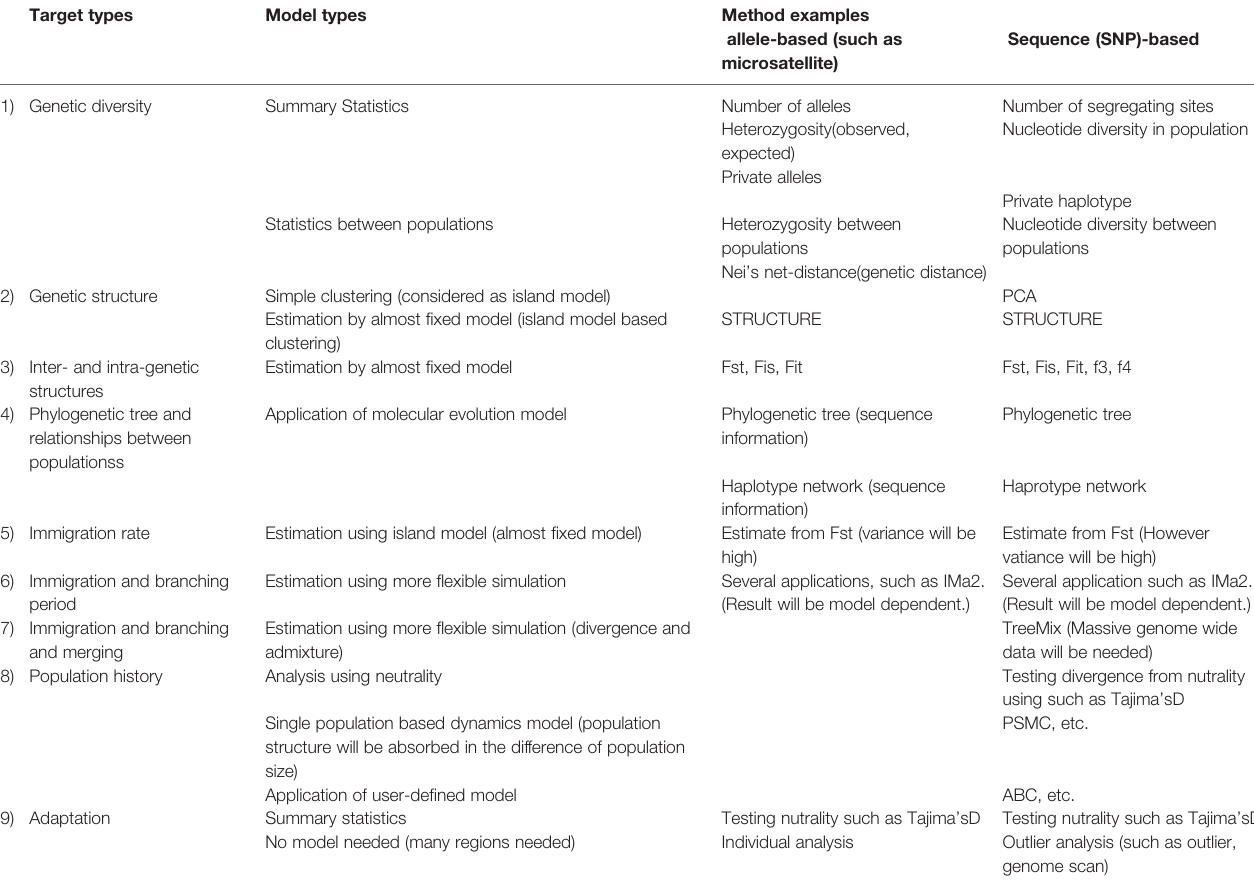
TABLE 2 | Types of genetic indicators and example of methods based on allele or